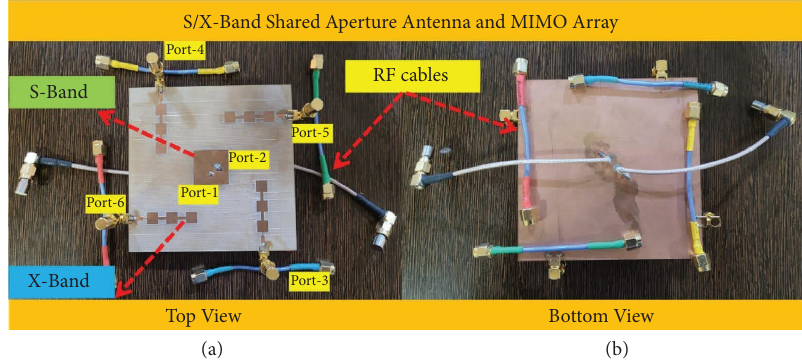
Figure 10: Fabricated prototype top and bottom view photograph of S/X-DBDP